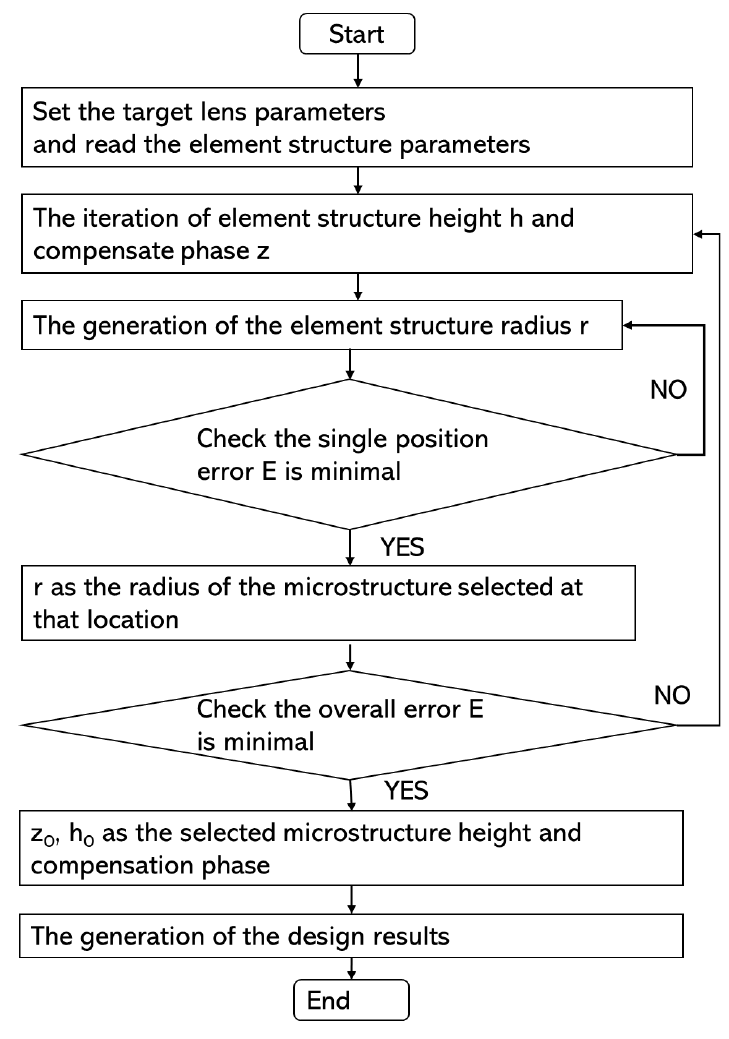
Figure 2. The workflow chart for the design process of the metalens.